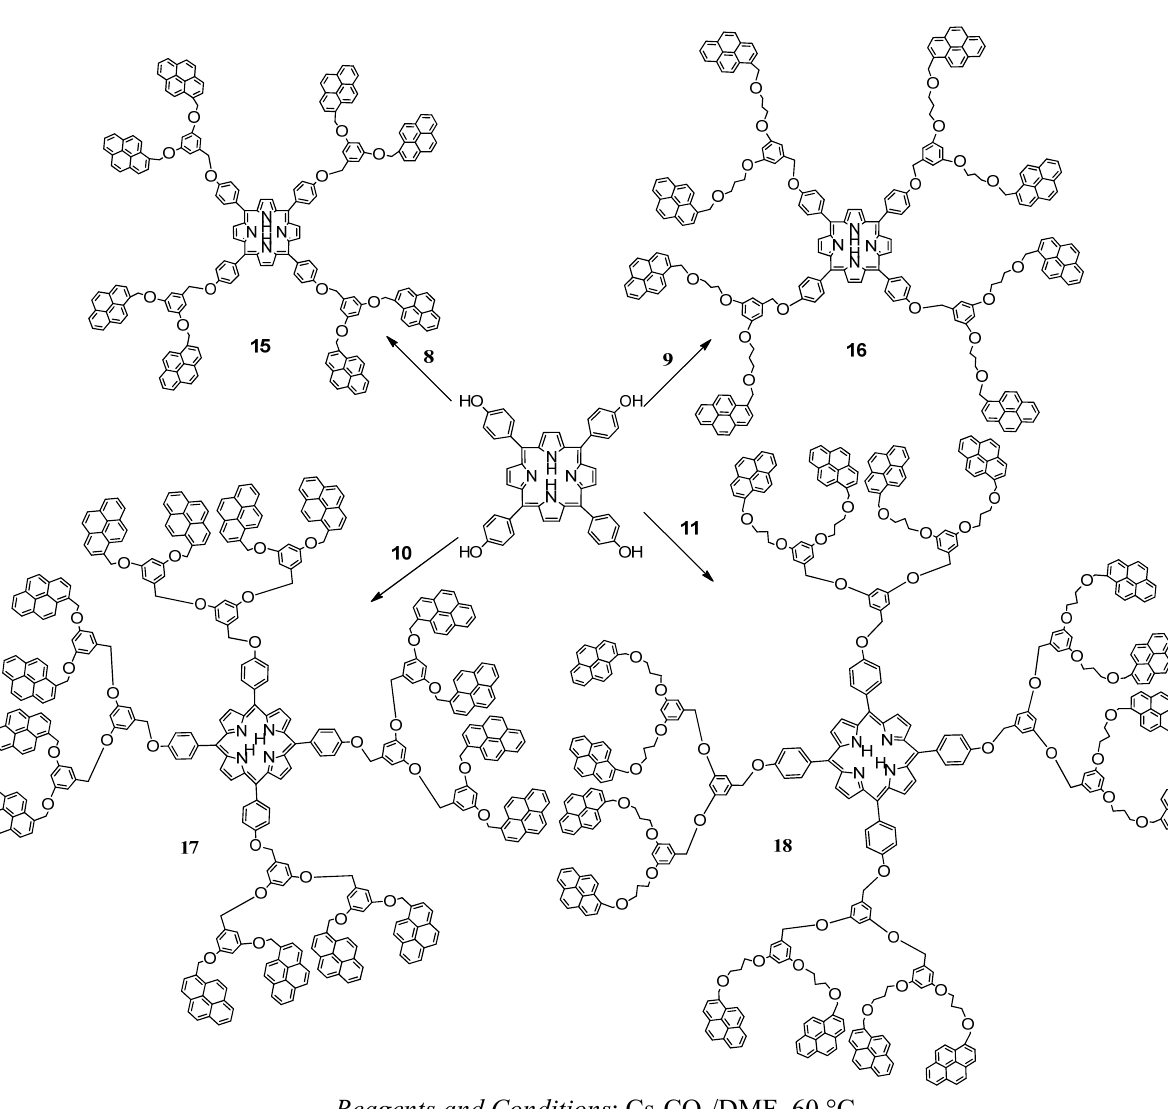
Scheme 3. Synthesis of dendrimers 15 – 18 .